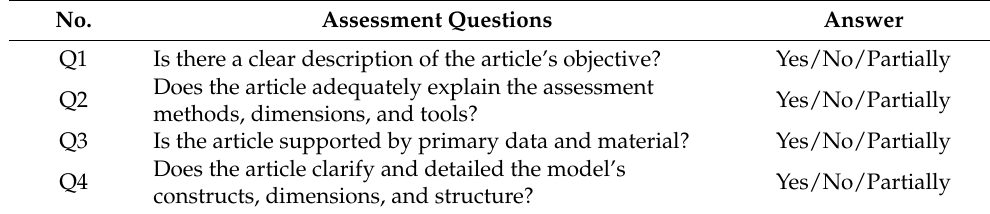
Table 2. Study Quality Assessment